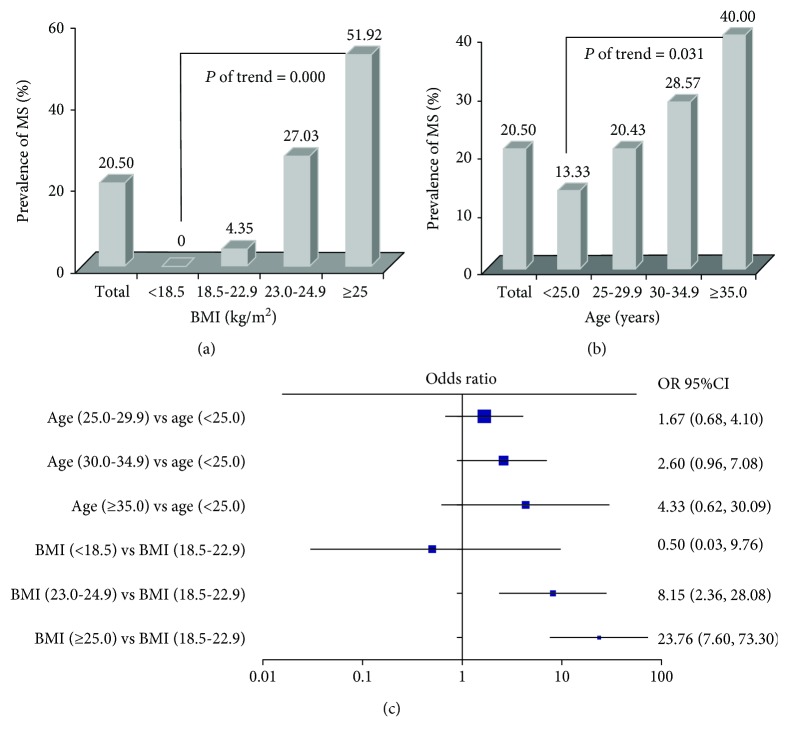
The effect of BMI (a) and age (b) on the prevalence of MS and the association of age and BMI (c) with the prevalence of MS in PCOS patients (n = 200).